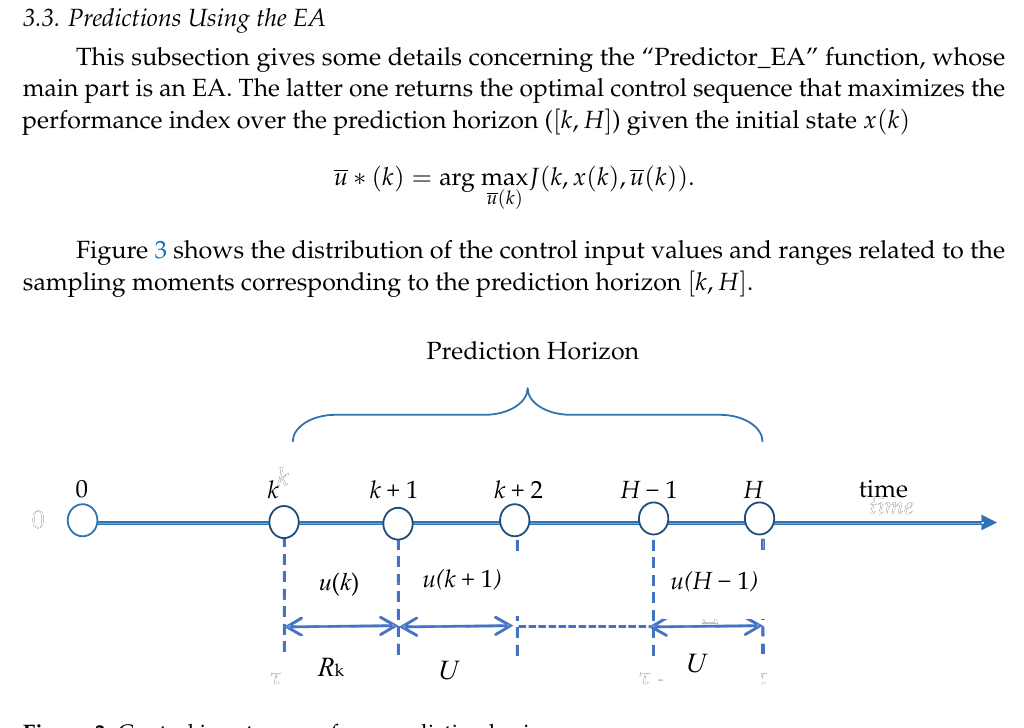
Figure 3. Control input ranges for a prediction horizon.